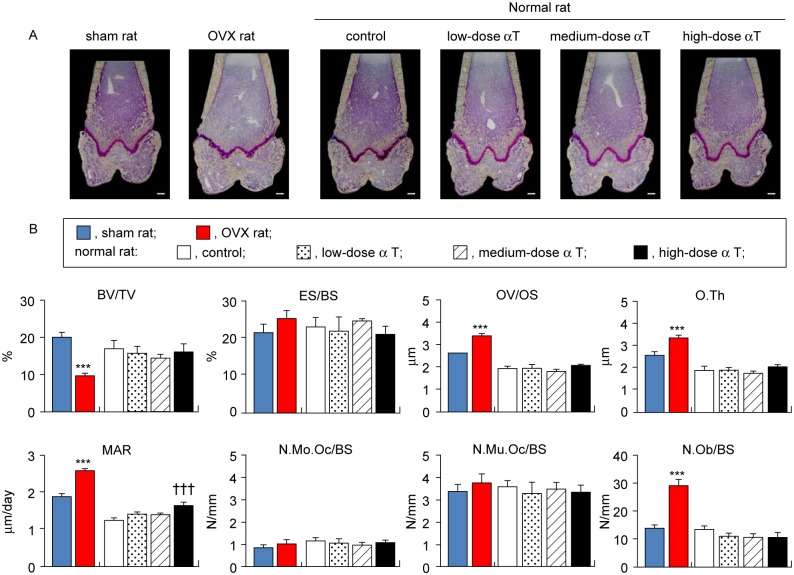
Histomorphometric analysis of secondary cancellous bones in distal femur metaphysis.(A) Representative micrographs of slices of frontal section of distal femur stained with Villanueva bone staining without decalcifying treatment are shown. (B) Histomorphometrical parameters (BV/TV, bone volume/tissue volume; ES/BS, eroded surface/bone surface; OV/OS, osteoid volume/osteoid surface; O.Th, osteoid thickness; MAR, mineral apposition rate; N.Mo.Oc/BS, number of mononuclear osteoclast/bone surface; N.Mu.Oc/BS, number of multinuclear osteoclast/bone surface; and N.Ob/BS, number of osteoblast/bone surface) of secondary cancellous bones in distal femur metaphysis are shown. Data are presented as mean ± standard error of the mean. ***P < 0.001 vs. sham rat group; †††P < 0.001 vs. normal rat control group.